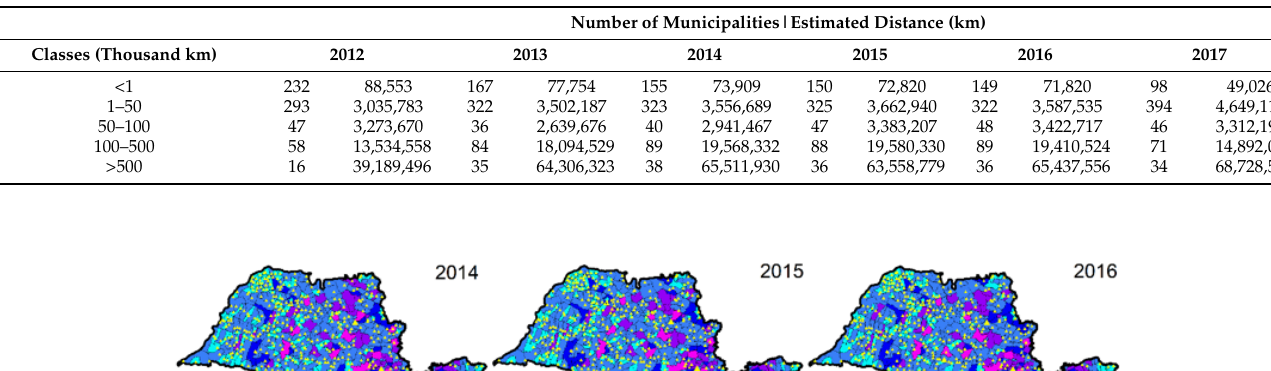
Table 5. Municipalities are grouped in the estimation of distance traveled by MSW truck’s vehicles classes by year and their full estimated length.